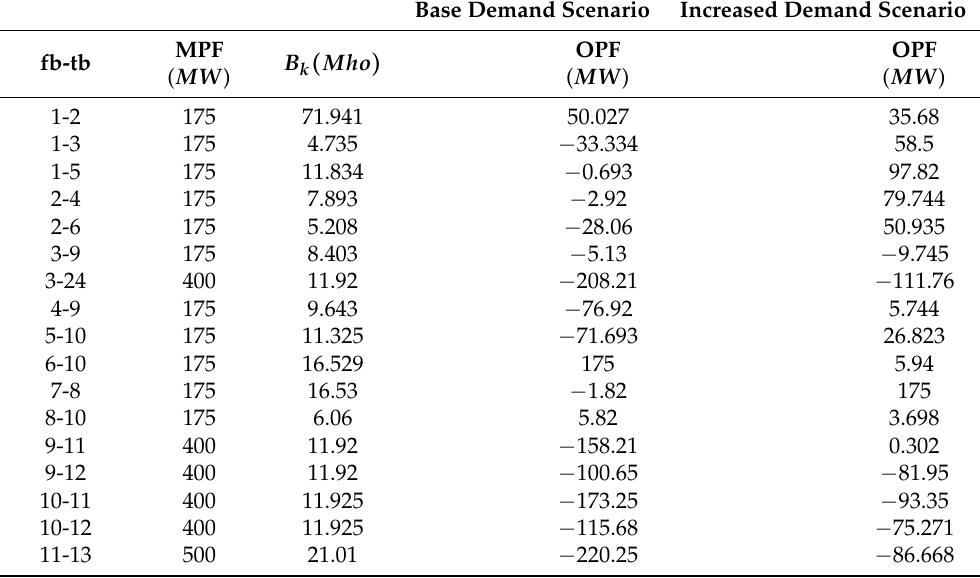
Table 10. Results of the optimal power flow of the 24-bus system with increase in demand.